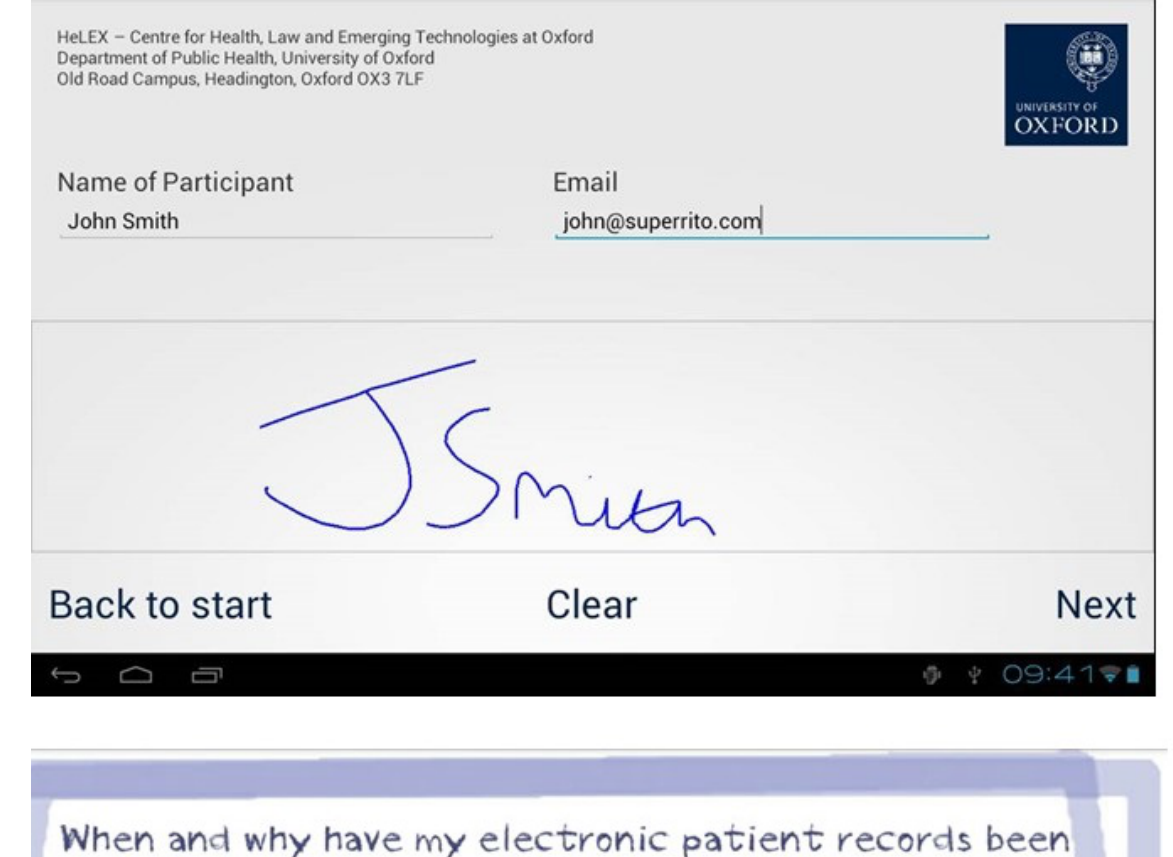
Figure 1. Dynamic consent interface. The origin of the image is from HW Communications and the University of